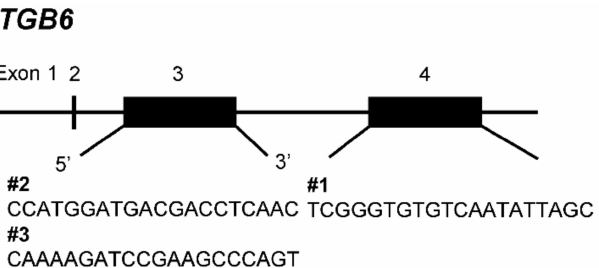
Figure 8. guideRNAs were designed complementary to target DNA sequences (#1–3) in exon 3 and exon 4 of integrin β 6 ( ITGB6